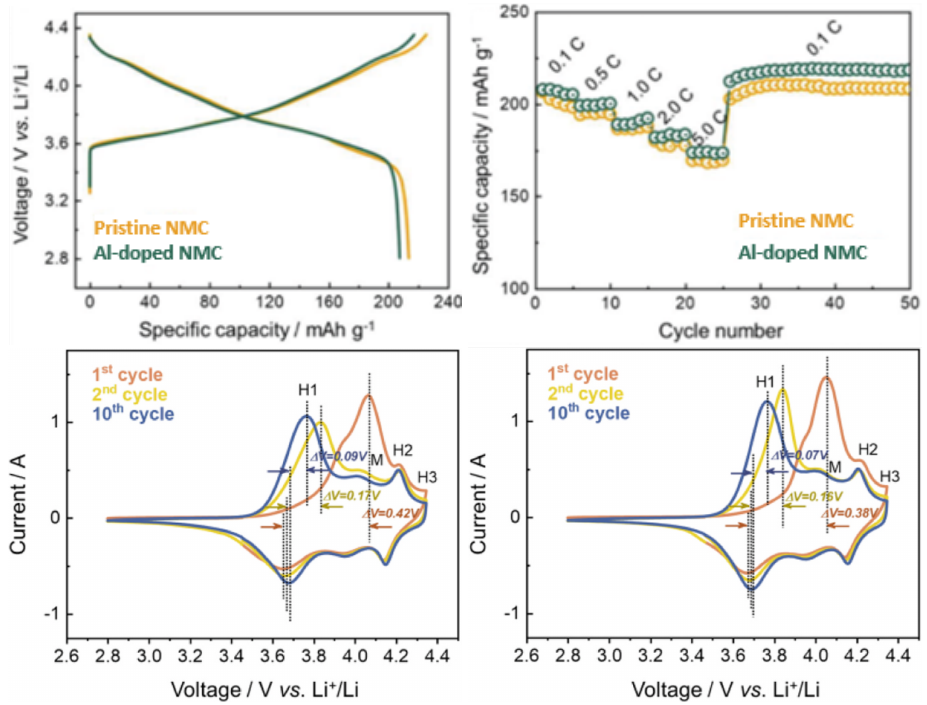
Figure 13. ( Top ) Charge/discharge and specific capacity for different rates for pristine and Al-doped LiNi 0.8 Mn 0.15 Co 0.05 O 2 , ( Bottom ) cyclic voltammetry curves for (left) pristine and (right) Al-doped LiNi 0.8 Mn 0.15 Co 0.05 O 2 . Reproduced with permission